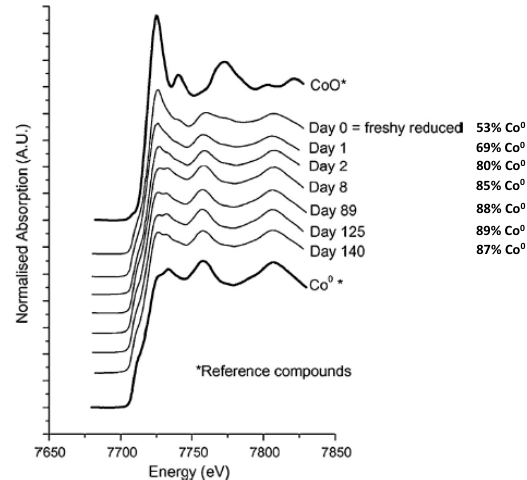
Figure 6. XANES analysis of a series of used Co/Pt/Al a 100 barrel/day slurry bubble column reactor operated at 220 °C, 2.0 MPa, (H conversions between 50% and 70%, feed gas composition = 50 vol.% H P(H O)/P(H ) = 1–1.5, P(H O) = 0.4–0.6 MPa. Reproduced with permission from [32]. 2 2 2